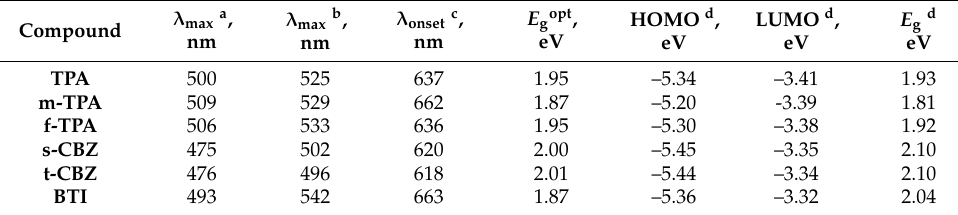
Figure 6. UV-vis absorption spectra of oligomers in THF solutions ( a ) and films cast from THF ( b ). Table 3. Optical and electrochemical data of oligomers .